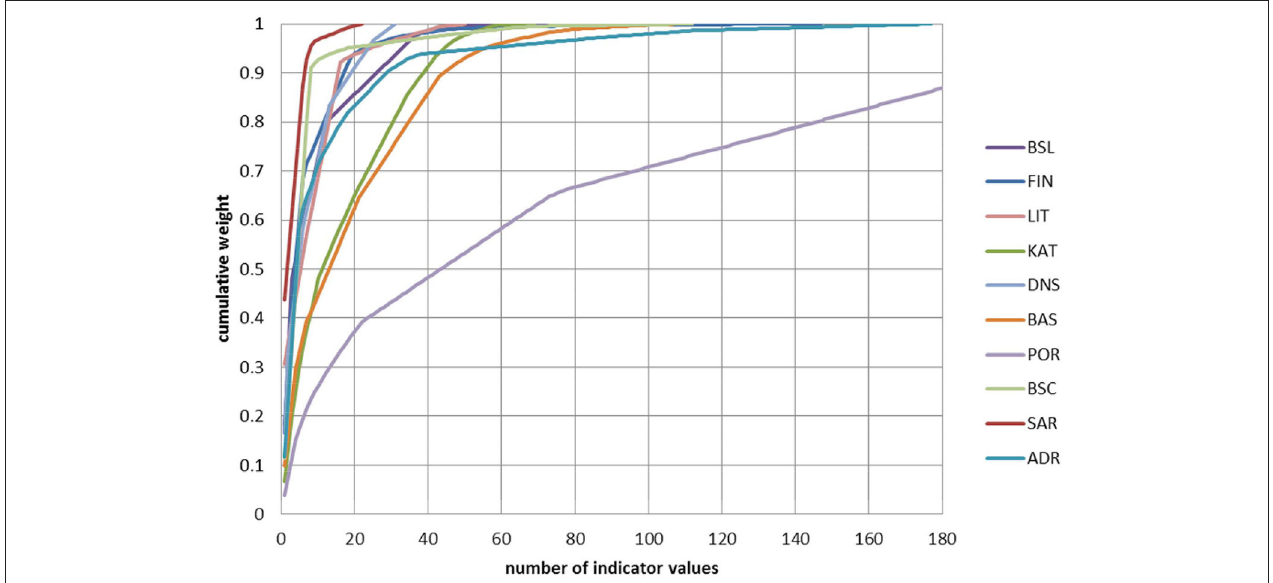
FIGURE 5 | Cumulative contribution to the final assessment (cumulative weight) in relation to the number of indicator values. For each case study, values have been ranked from the most important indicator value (highest weight) to the least important value (lowest weight). The X-axis has been cut; Portuguese case study has a total of 466 indicator values. For case study codes, see Table 1